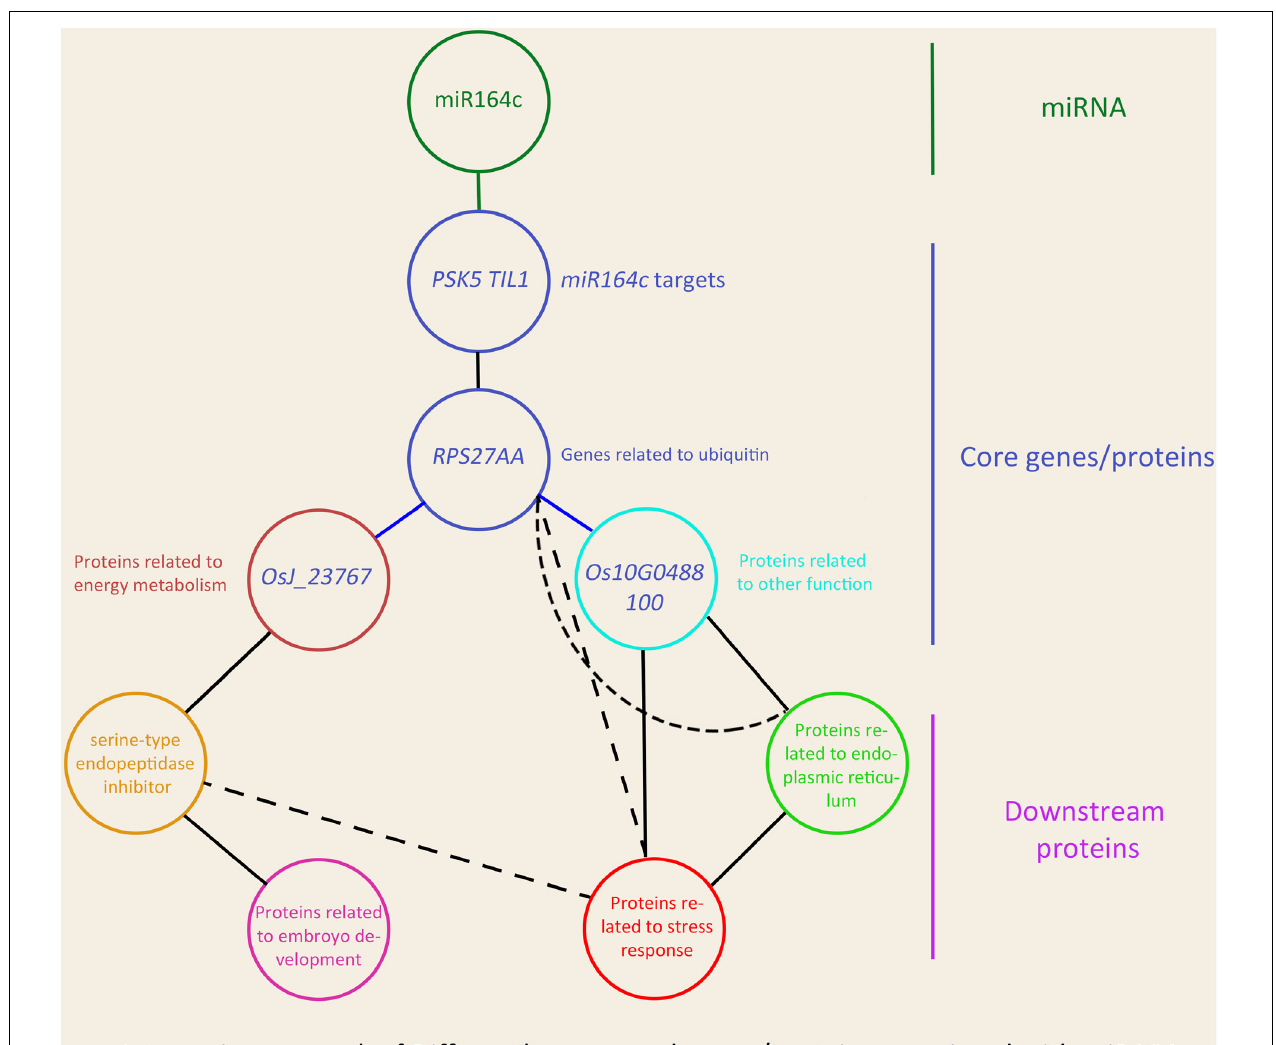
FIGURE 10 | Schematic showing the effect of miR164c on rice seed vigor via RPS27AA in the functional gene/protein interaction network. Solid straight lines represent strong interaction, and dashed lines represent weak interaction. The color of the outer frame of each node is the same as that of the functional proteins in Figure 9 . Blue lines represent the interactions confirmed both by the MERLIN algorithm and String